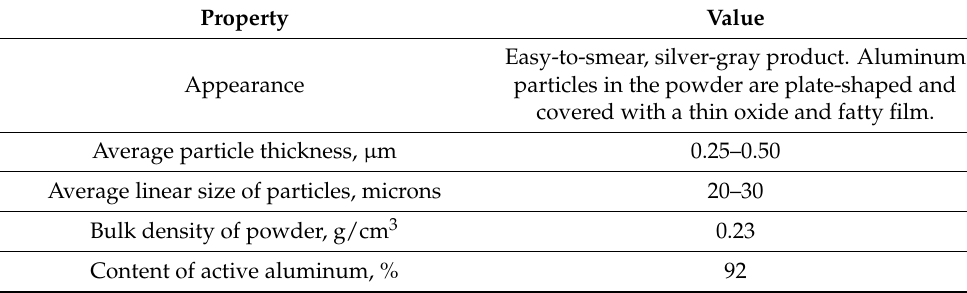
Table 5. Characteristics of aluminum powder PAP-1.